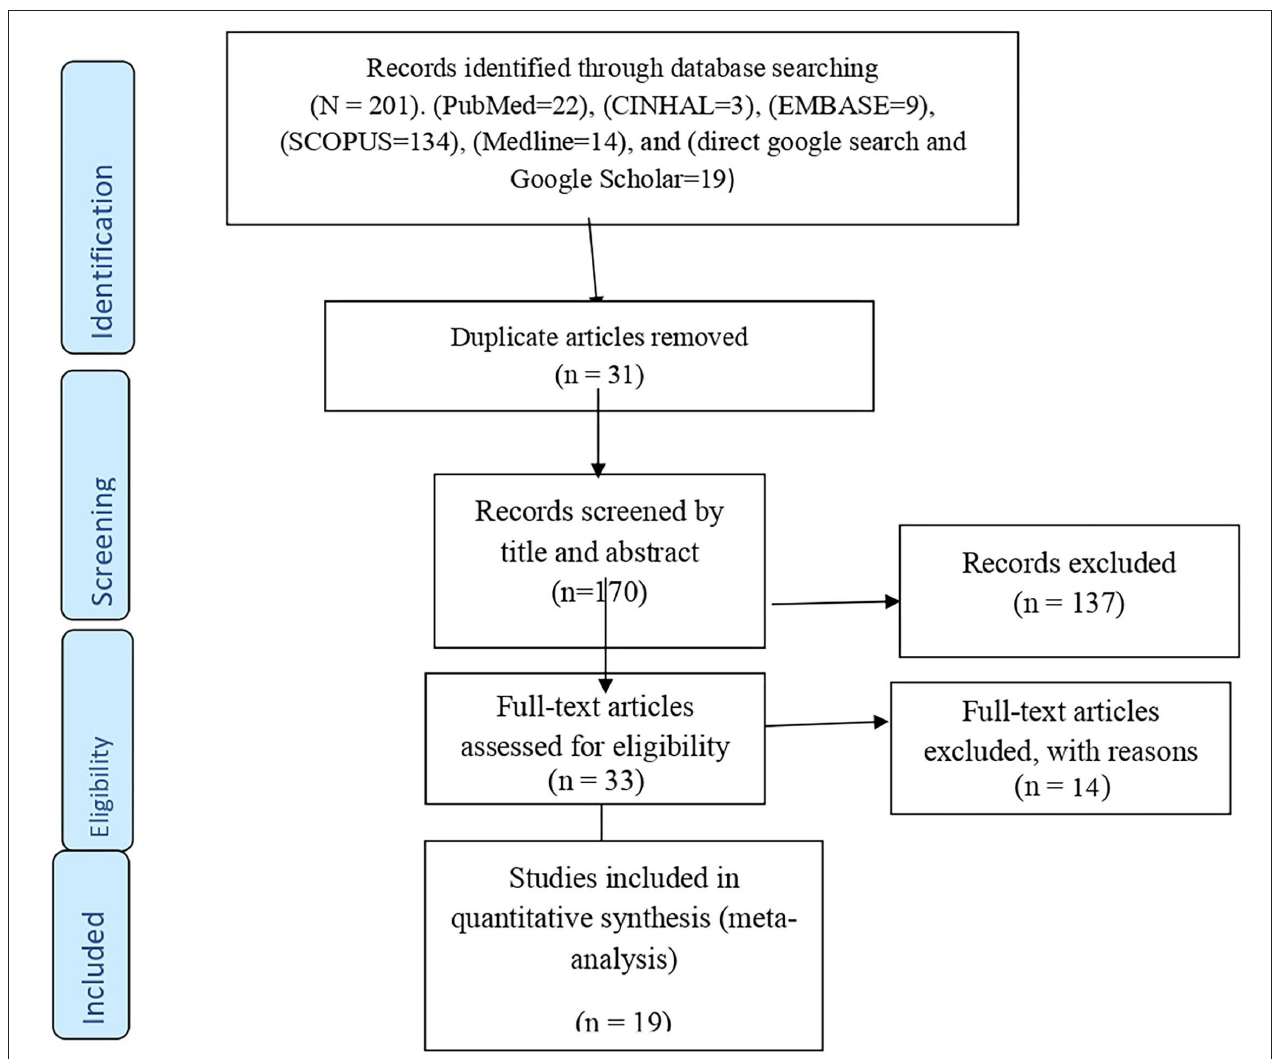
FIGURE 1 | PRISMA flow diagram showing the selection process of eligible articles for systematic review and